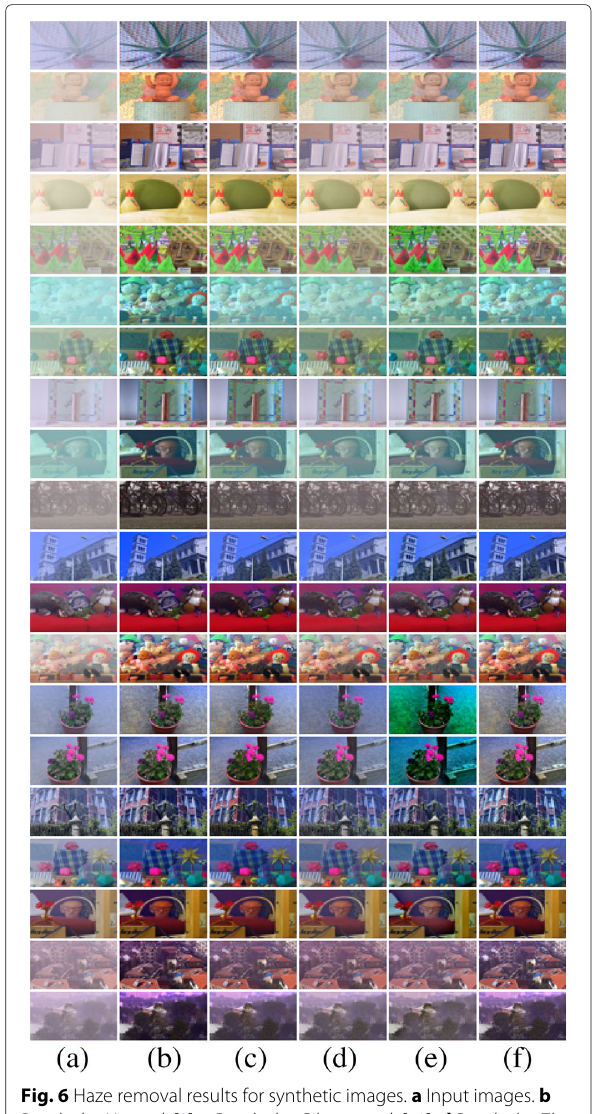
Fig. 6 Haze removal results for synthetic images. a Input images. b Results by He et al. [8], c Results by Gibson et al. [10], d Results by Zhu et al. [11], e Results by Ren et al. [12], f Our